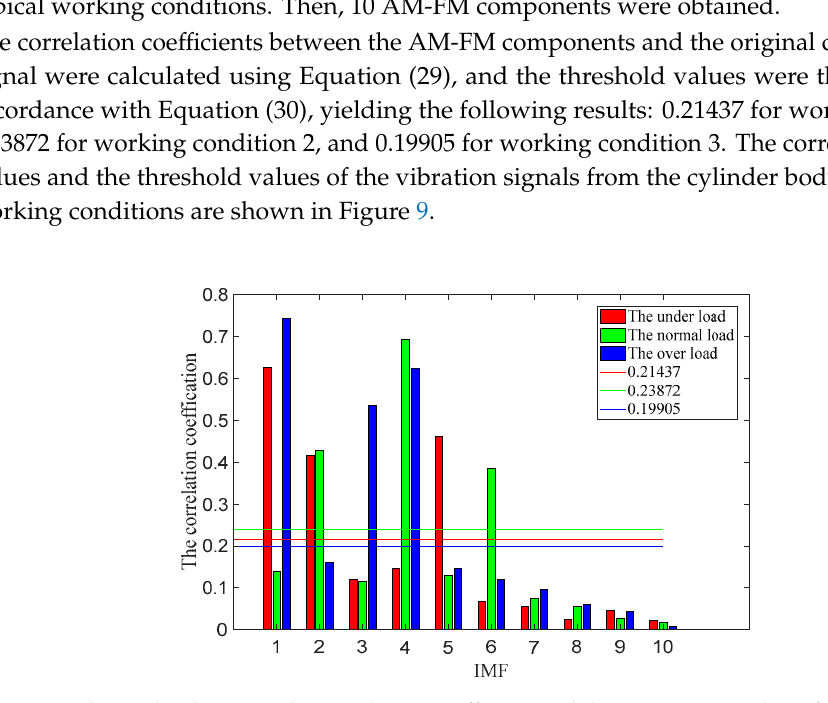
Figure 9. Relationship between the correlation coefficient and the sequence number of the amplitude modulation–frequency modulation (AM-FM) component.